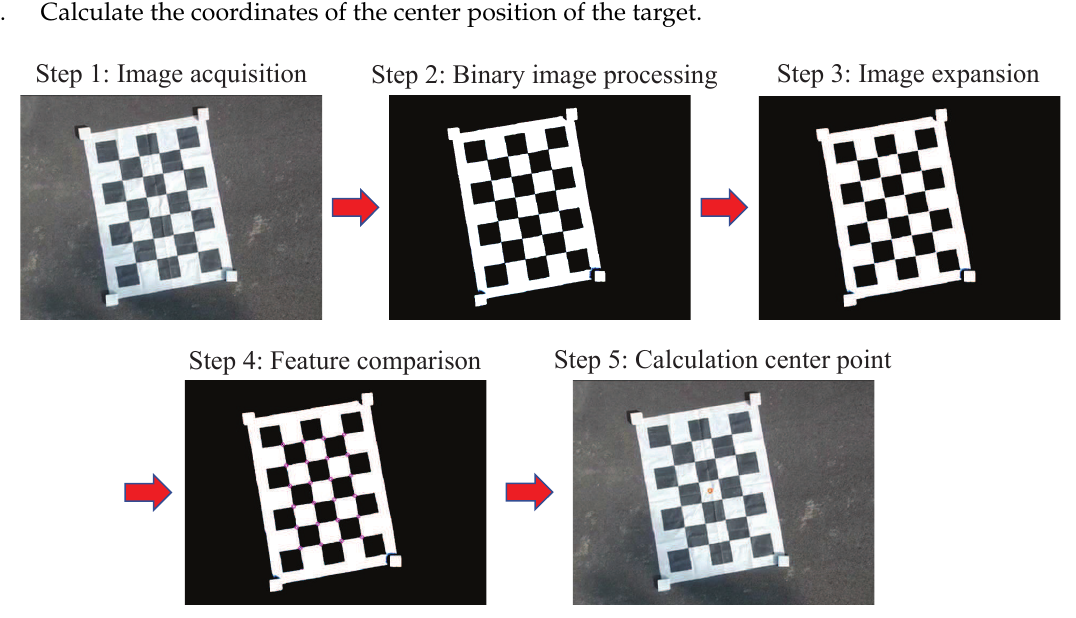
Figure 7. Method for identifying and obtaining the feature point